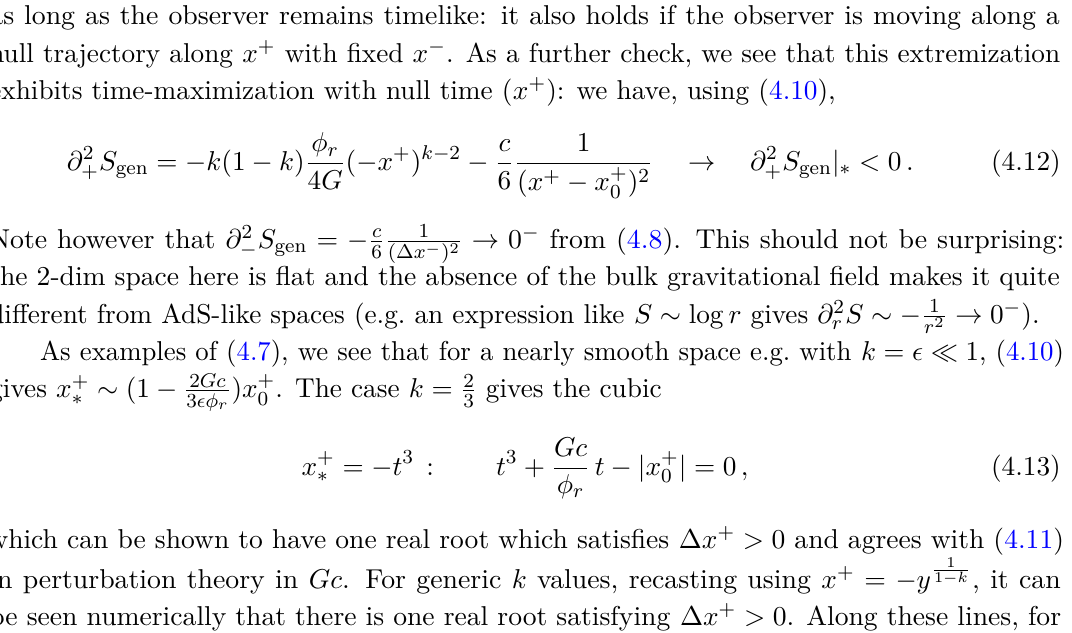
Figure 3 . Cartoon of the 2-dim geometry with the null singularity at x + = 0 , the worldline ( x + of a timelike observer (vertical trajectory, representing for simplicity a fixed spatial location), and the quantum extremal surface at ( x + , x − ) . As can be seen, the QES is spacelike separated from ∗ ∗ the observer ( ∆ 2 > 0 ) if ∆ x + > 0 and ∆ x − ∼ −∞ , and lies towards the singularity in terms of x + -slices. The entanglement wedge defined by the QES is shown as the blue